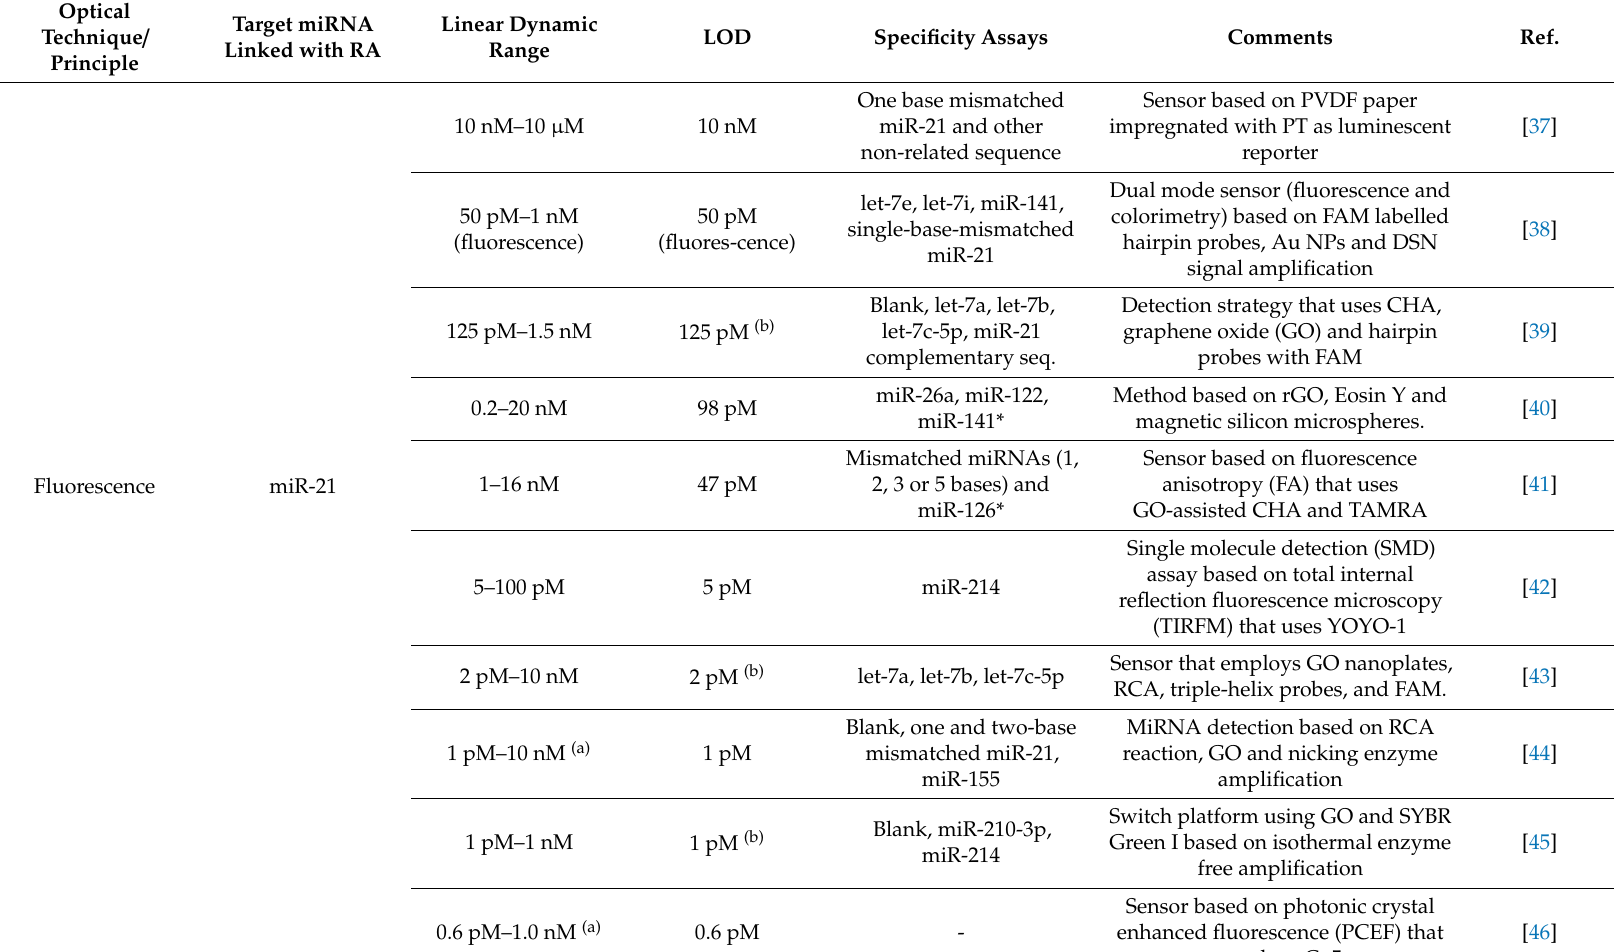
Table 1. Optical biosensors for the detection of microRNAs (miRNAs) linked with rheumatoid arthritis